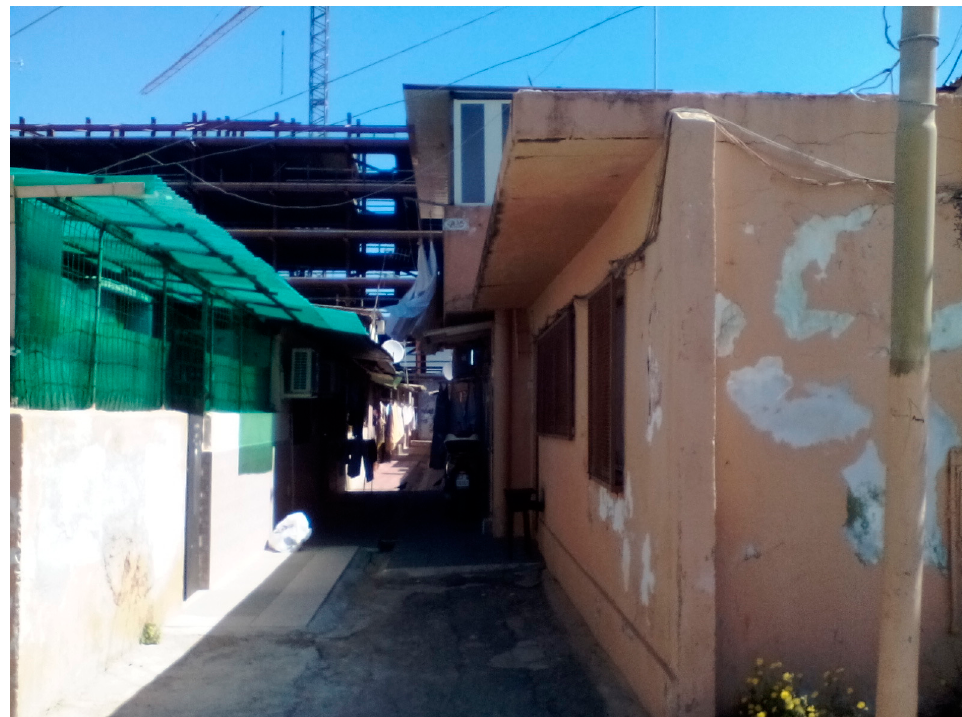
Figure 2. A detail of the slums (2015) .